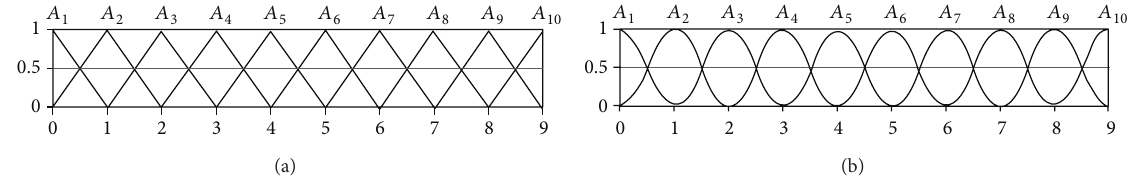
Figure 3: (a) Ruspini partitions with triangular basic function; (b) Ruspini partitions with cosine basic function.